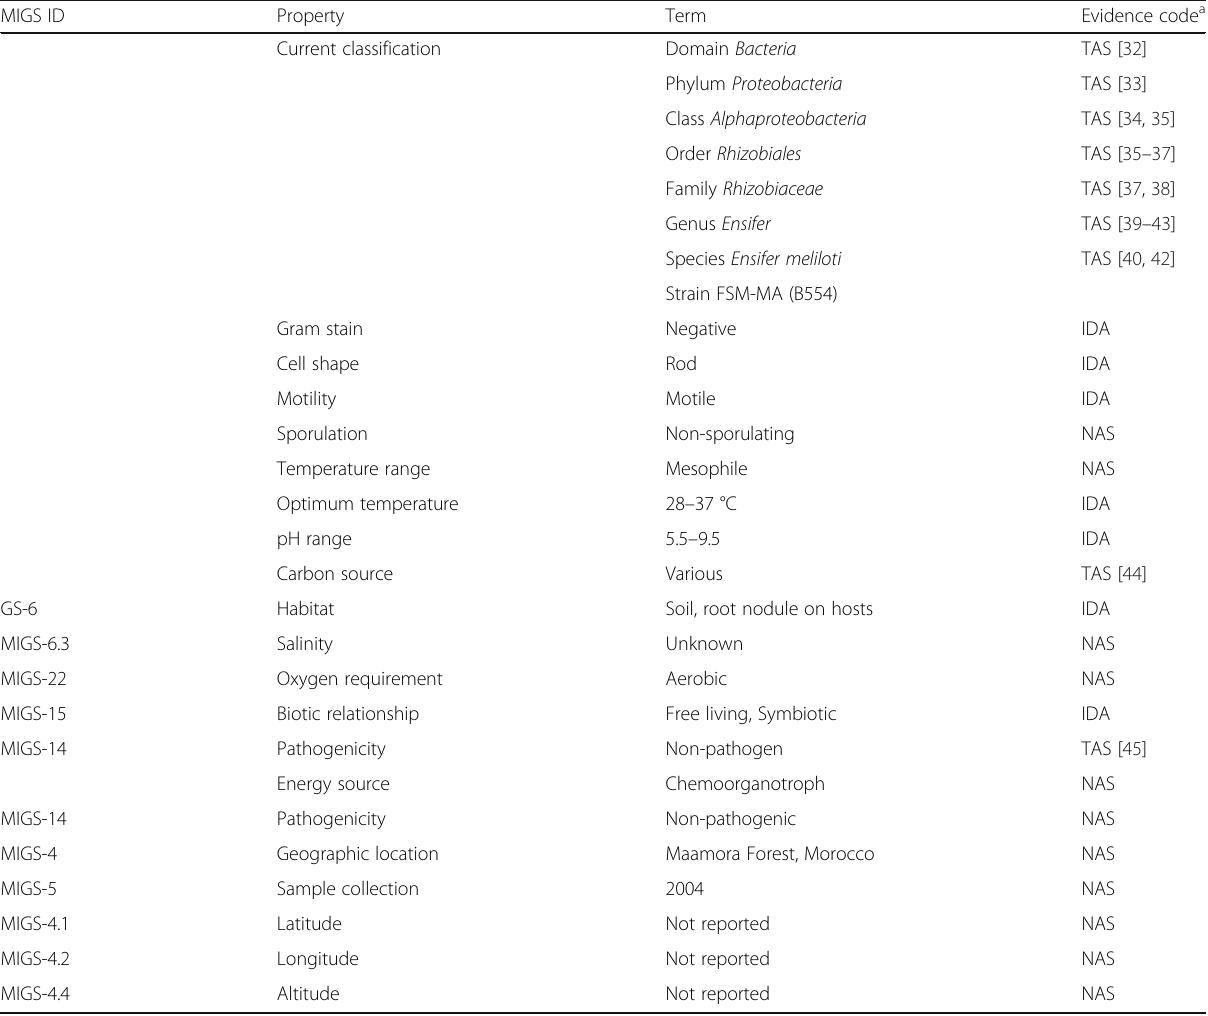
Table 1 Classification and general features of E. meliloti strain FSM-MA MIGS